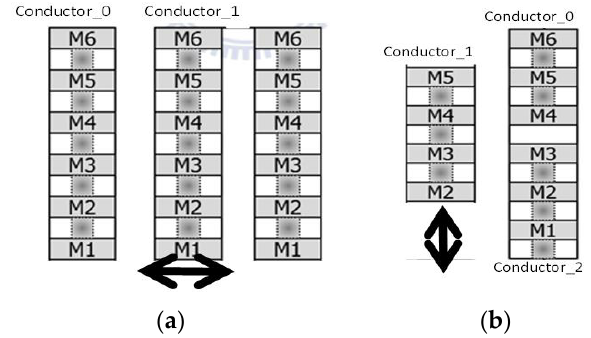
(cid:105) × 0.8 × N = 14.41 fF (Figure 4b), and N = 18, which corresponds to the x- and y-axes.